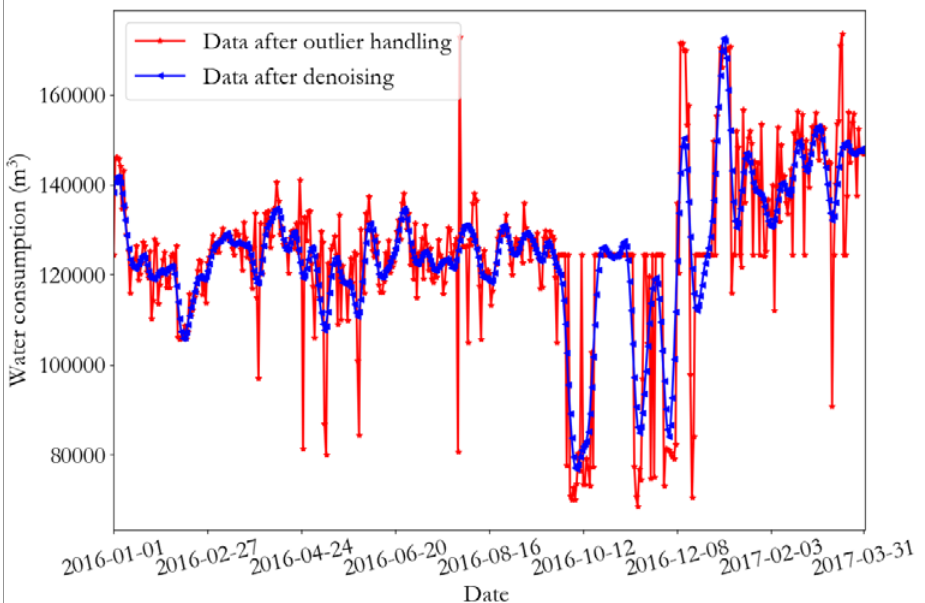
Figure 4. Data after removing outliers and after de-noising of the monitoring point 1.